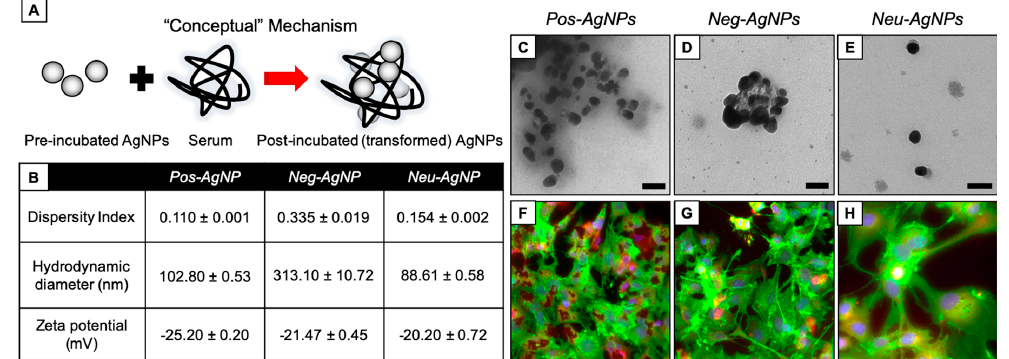
Figure 4. AgNP transformation after incubation in serum. ( A ) Conceptual model of